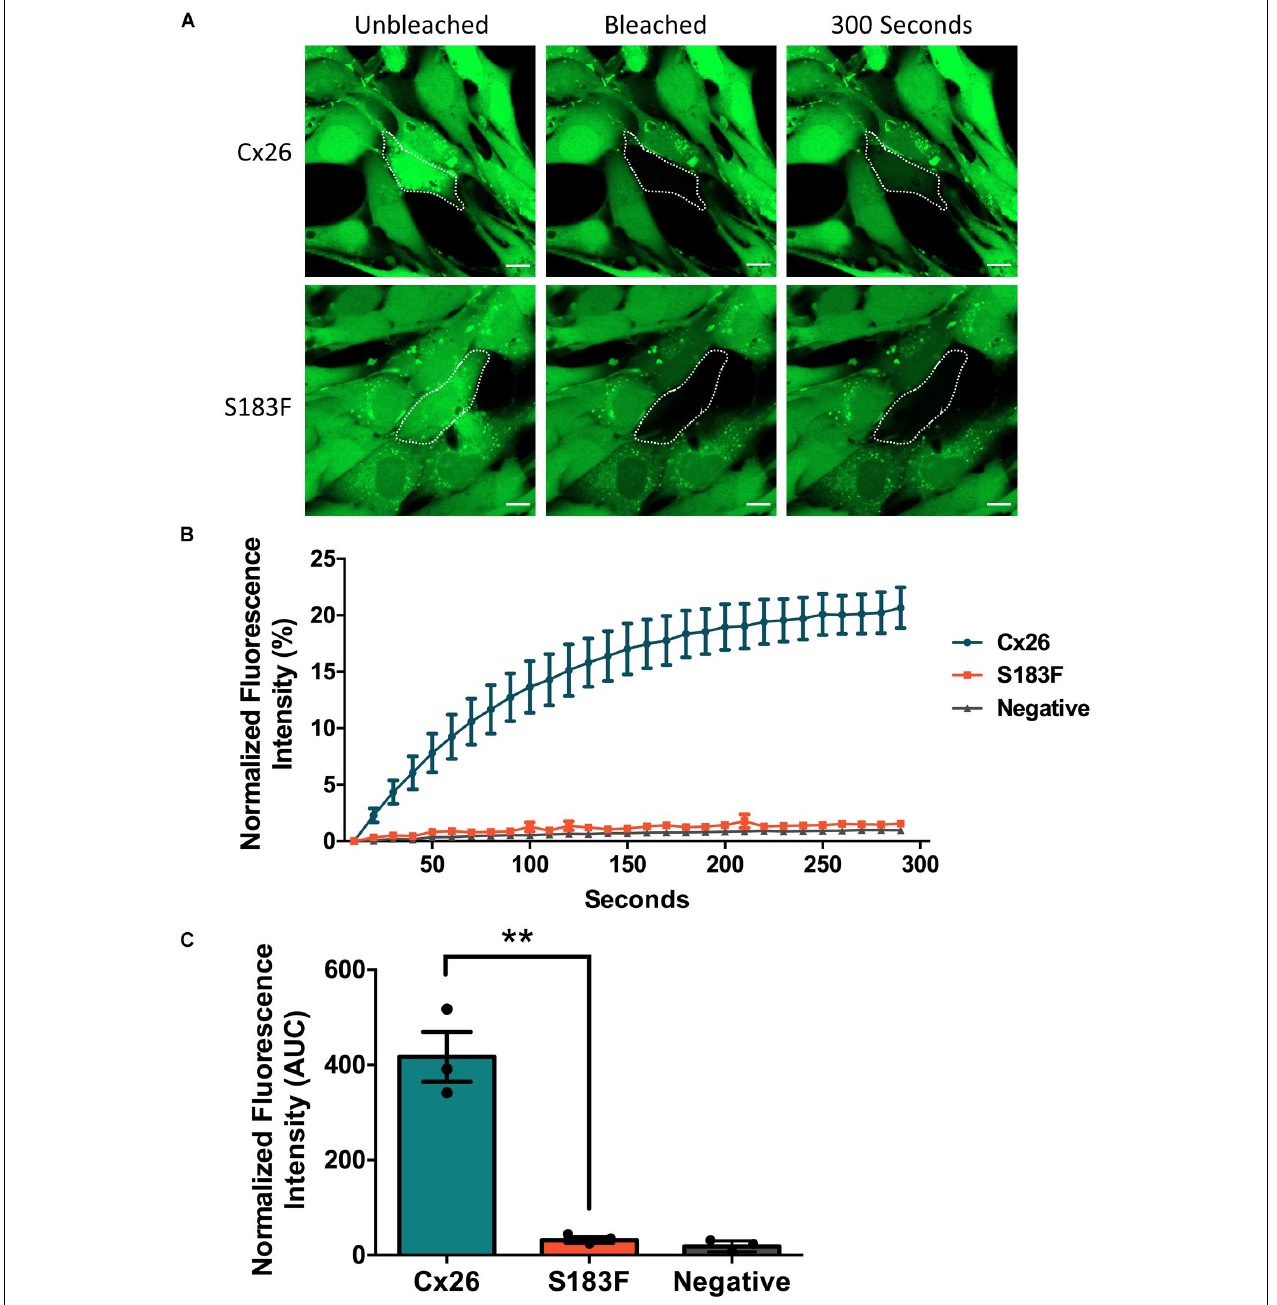
FIGURE 4 | The S183F mutant does not form dye-permeable gap junction channels. (A) Negative (Cx43 KO cells) or Cx43 KO cells expressing Cx26-GFP or S183F-GFP were loaded with gap junction permeable dye calcein-AM (green) and subjected to FRAP. (B) A selected cell within a pair or cluster of Cx26 or S183F mutant expressing cells was photobleached and dye recovery over 300 s was measured. (C) Area under the curve (AUC) of fluorescence recovery was measured. Cx43 KO cells and cells expressing the S183F mutant had negligible dye recovery while WT Cx26 expressing cells exhibited significant dye recovery. Data represents mean ± SEM of three independent experiments and were analyzed using an unpaired t -test, ** p < 0.01. Bars = 10 µ